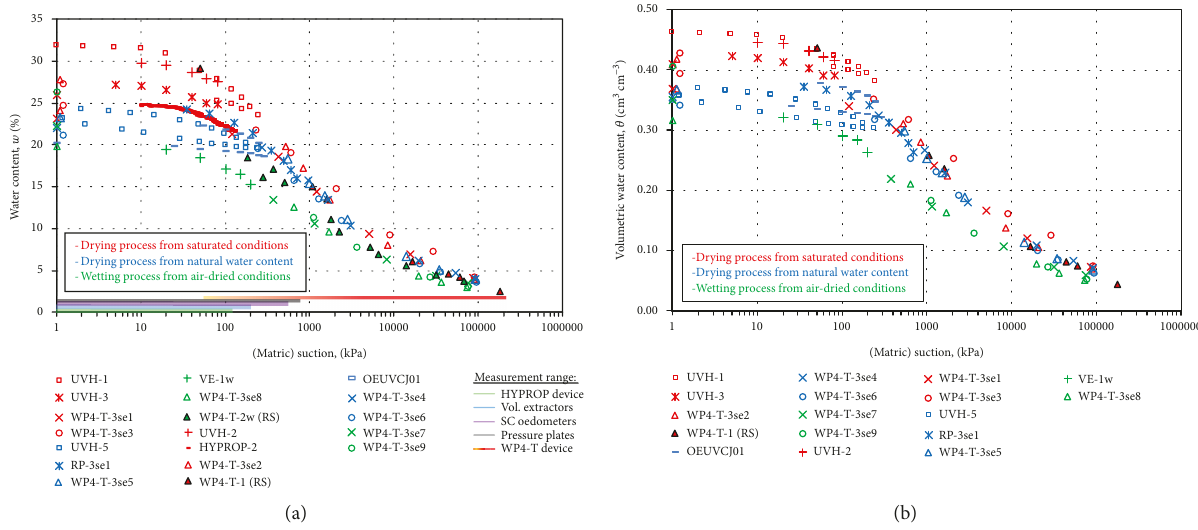
Figure 5: SWCC in terms of (a) gravimetric water content and (b) volumetric water content for the drying and wetting processes. Symbol (RS) indicates remolded samples; all other samples are undisturbed.